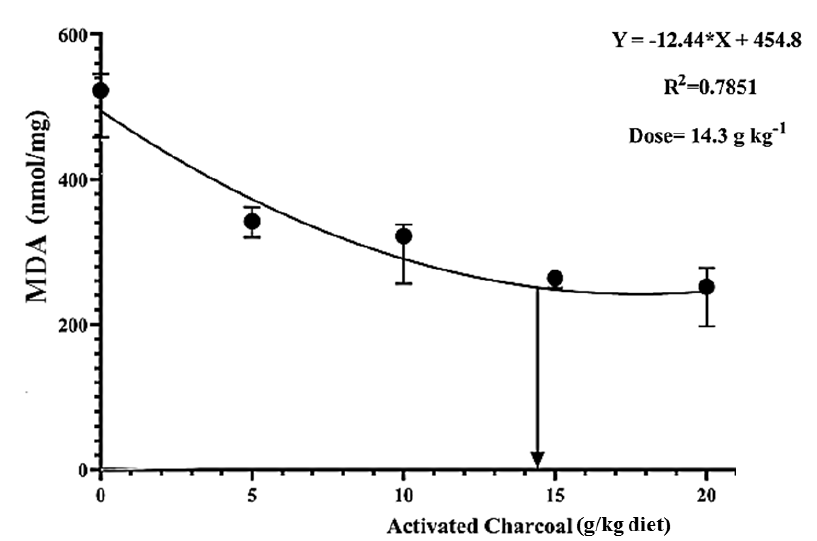
Figure 5. Second-order polynomial regression equation between malondialdehyde (MDA) levels of Nile tilapia fed different dietary activated charcoal (AC) levels for 8 weeks and then exposed to a sub-lethal imidacloprid (IMID) level for 2 weeks. Values expressed as means ± S.E.M.